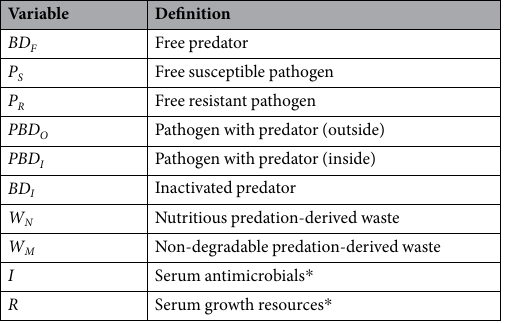
Table 1. Model variables and definitions for both the buffer and human serum predation models. The variables marked with * are present in the serum model